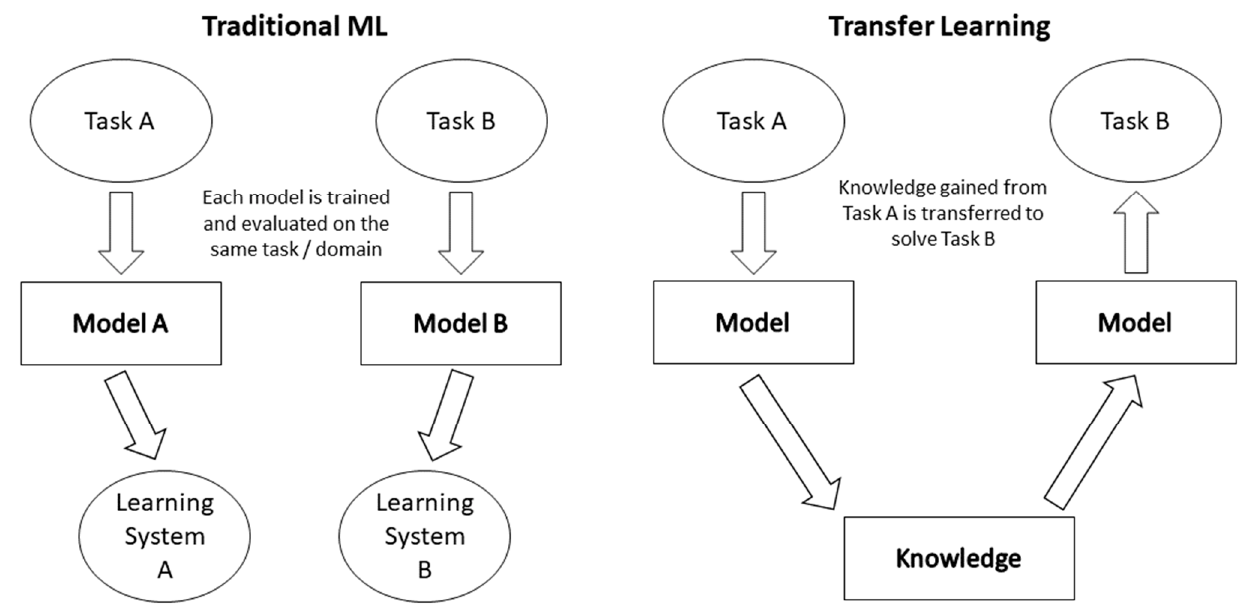
Figure 3. Transfer learning compared with traditional machine learning (ML) tasks.